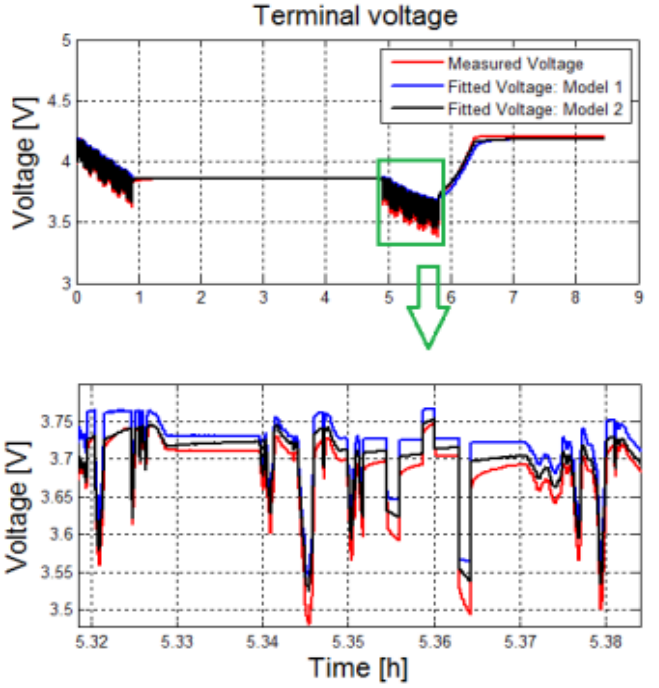
Figure 8. Model fitting to the measured data.